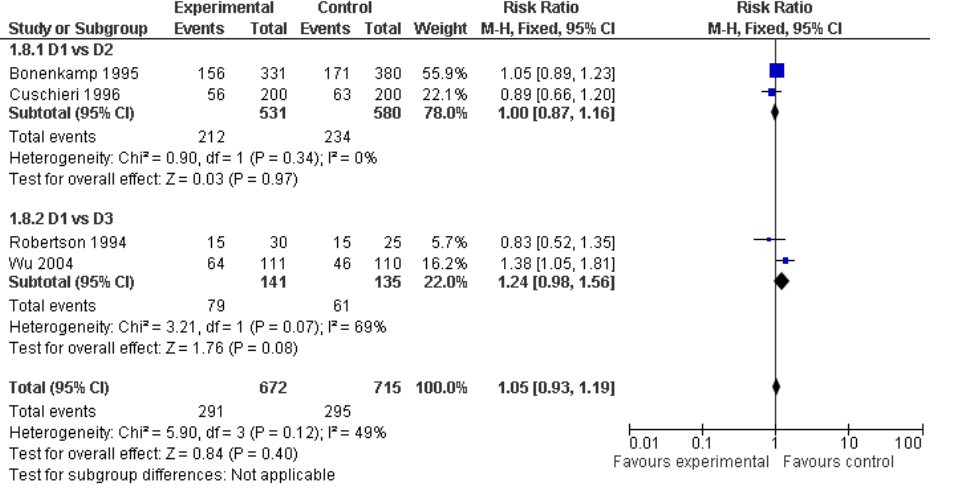
FIGURE 8 – Meta-analysis of 5-year survival. Effects estimates (odds ratio; 95% CI). Pooled treatment effect is shown as a diamond that spans the 95% CI. No significant statistical heterogeneity between studies results. Overall effect with no statistically significant difference between D1 and D2 or D3 lymphadenectomy